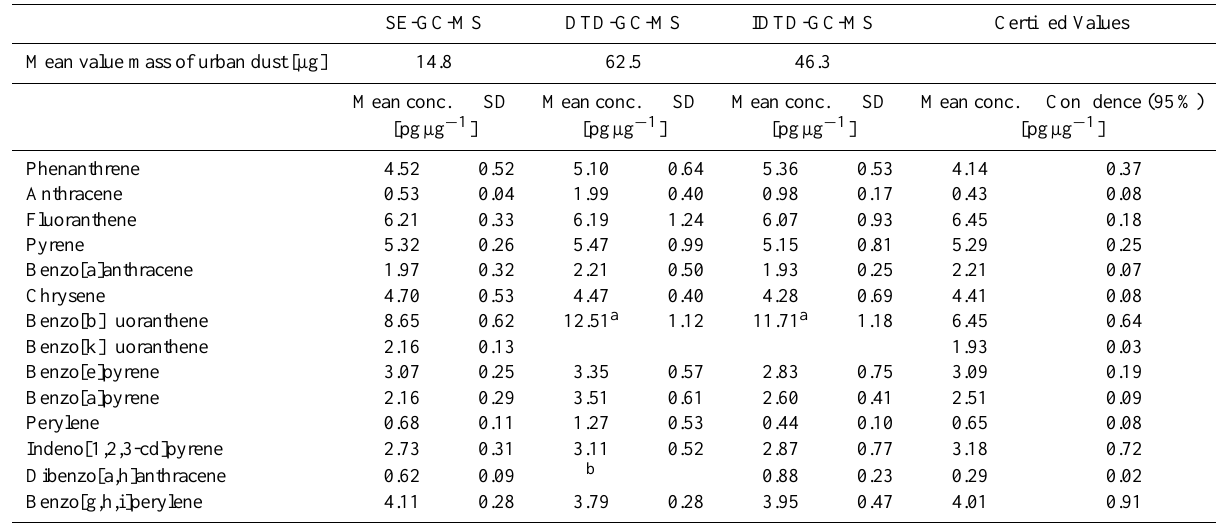
Table 2. Concentration of PAH in NIST Standard Reference Material 1649a (Urban Dust).